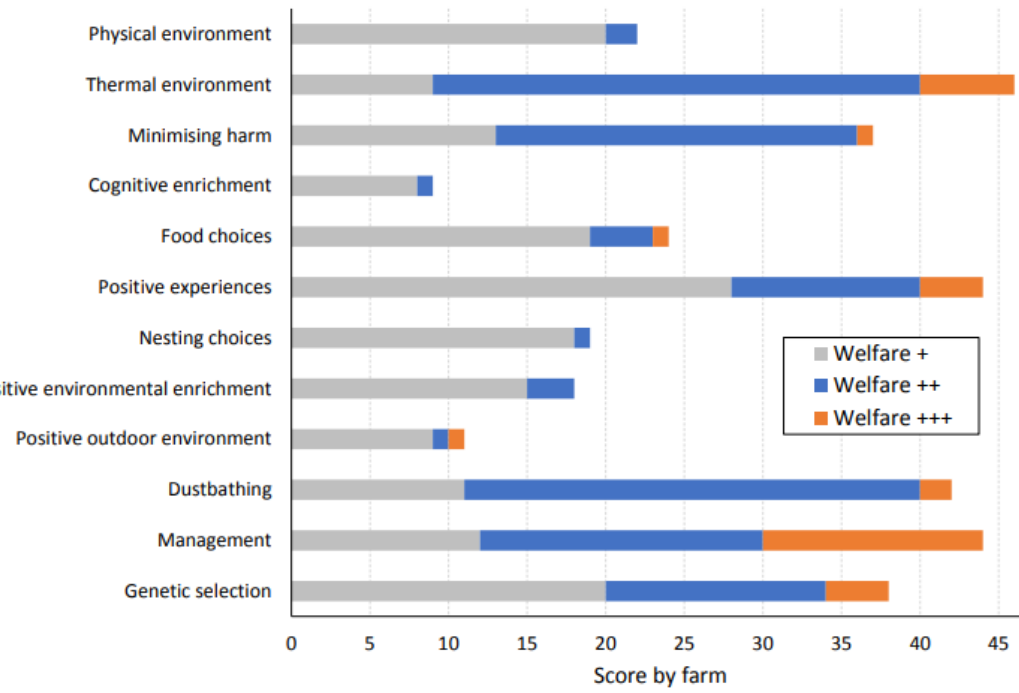
Figure 2. Number of flocks (out of 49) that achieve each of 13 resource needs.